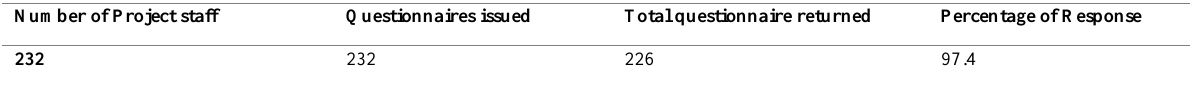
Table 1: Questionnaire response rate